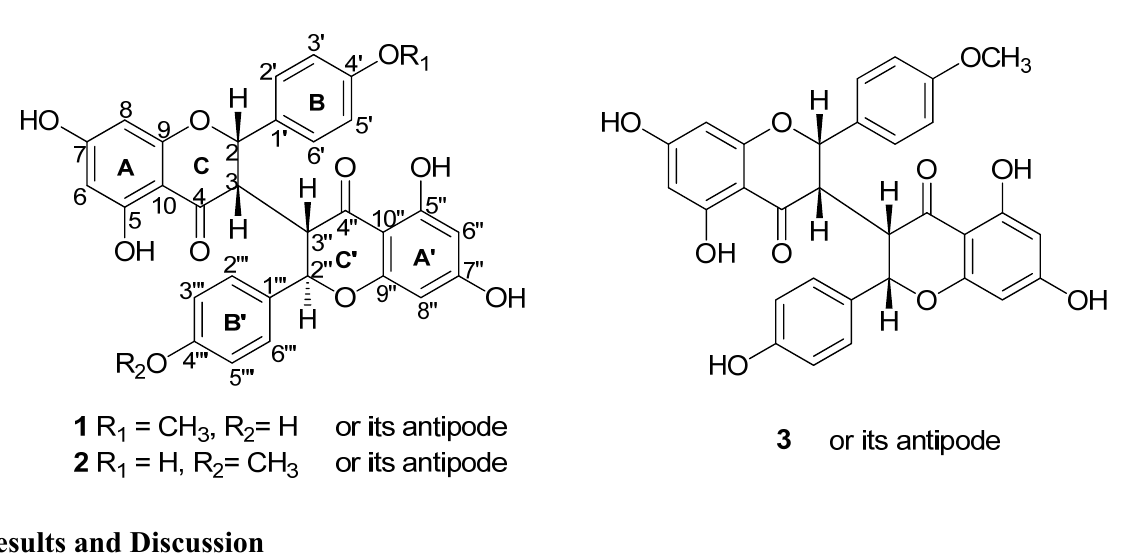
Figure 1. Chemical Structures of 1–3